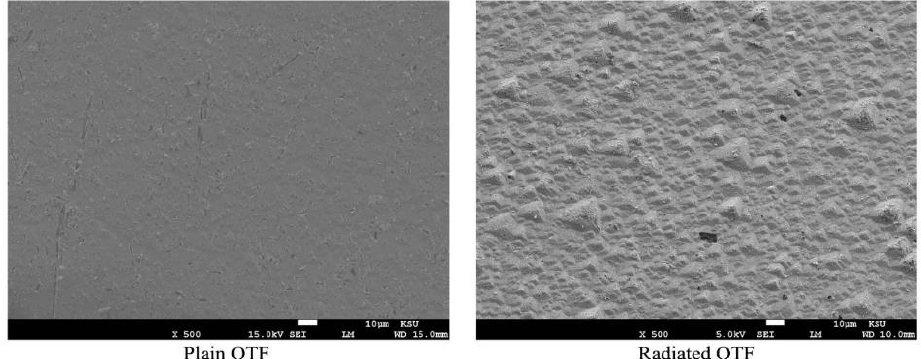
Figure 6. SEM images of QTF g before and after irradiation.